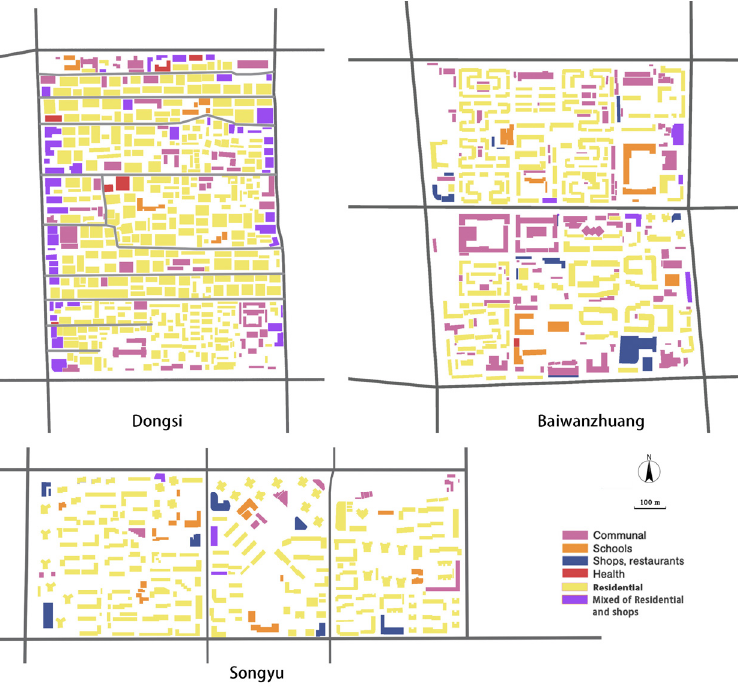
Figure 7. Building types in the